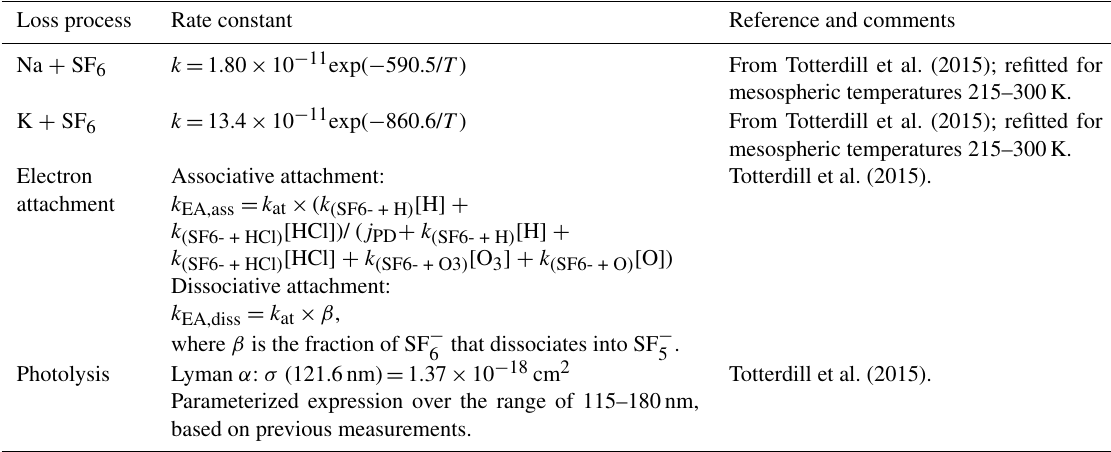
Table 1. SF 6 loss reactions included in